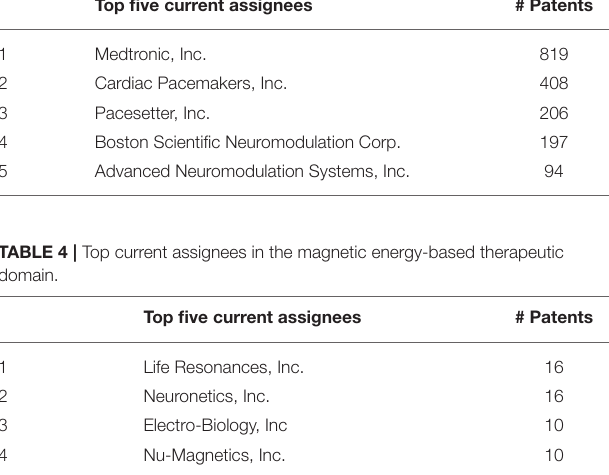
TABLE 3 | Top 5 current assignees in the electrical energy–based therapeutic domain. Top five current assignees